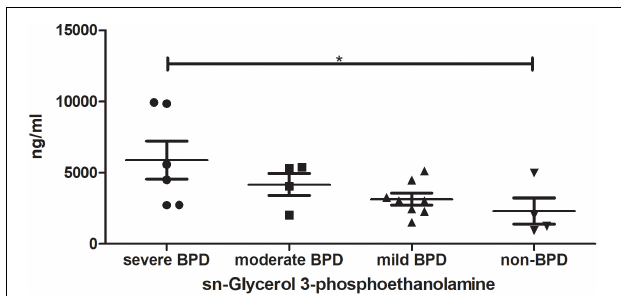
FIGURE 4 | sn-Glycerol 3-phosphoethanolamine level at birth (Day 1). * P < 0.05 (sever BPD group: n = 6; moderate BPD group: n = 4; mild BPD group: n = 8; non-BPD group: n = 4).